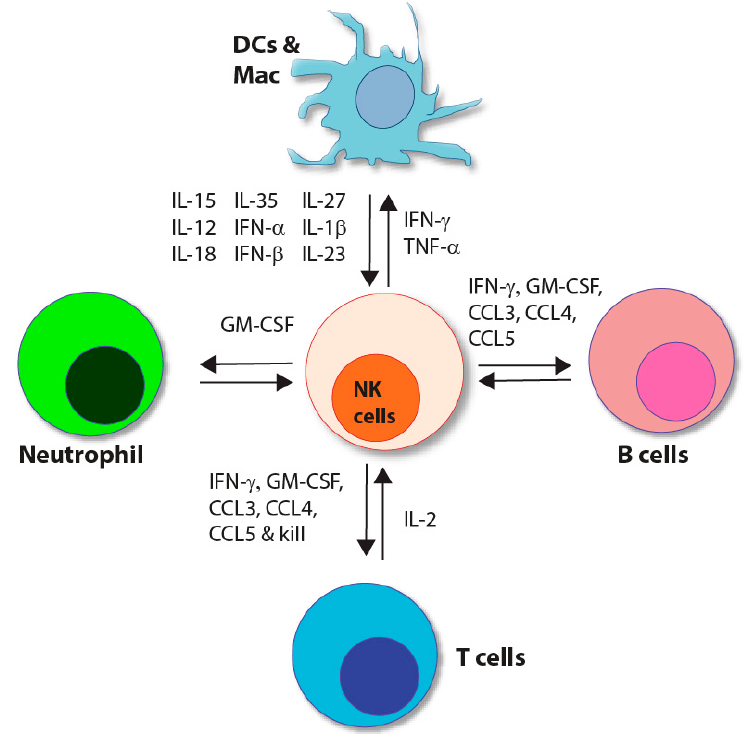
Figure 1. Bi ‐ directional interaction of NK cells with other immune cells. A brief representation of NK cells’ significant interactions and the innate (myeloid ‐ derived) and adaptive (T and B cell) immune system. Myeloid ‐ derived cells (dendritic cells, macrophages, and neutrophils) secrete various cytokines and chemokines, regulating NK cell effector functions. NK cells secrete cytokines and chemokines (IFN ‐γ , TNF ‐ a, GM ‐ CSF, CCL ‐ 3, CCL ‐ 4, and CCL ‐ 5) to regulate lymphoid ‐ derived cells (T and B cells).